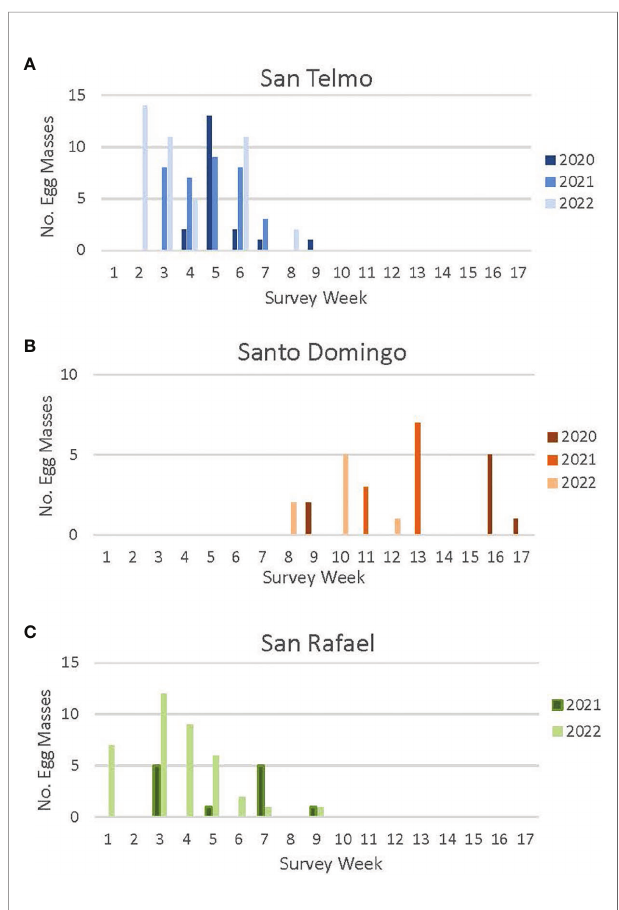
FIGURE 2 | Egg mass detections at three R. draytonii source sites [San Telmo (A) , Santo Domingo (B) , San Rafael (C) ] in Baja California in 2020, 2021 and 2022. Week 1 = First week of January; Week 17 = Fifth week of April. Annual surveys started earlier each year as the timing of breeding was better understood (surveys were initiated the fourth week of January in 2020, the third week of January in 2021, and the fi rst week of January in 2022). Survey schedules varied from year to year. See Appendix II for a complete survey schedule for each